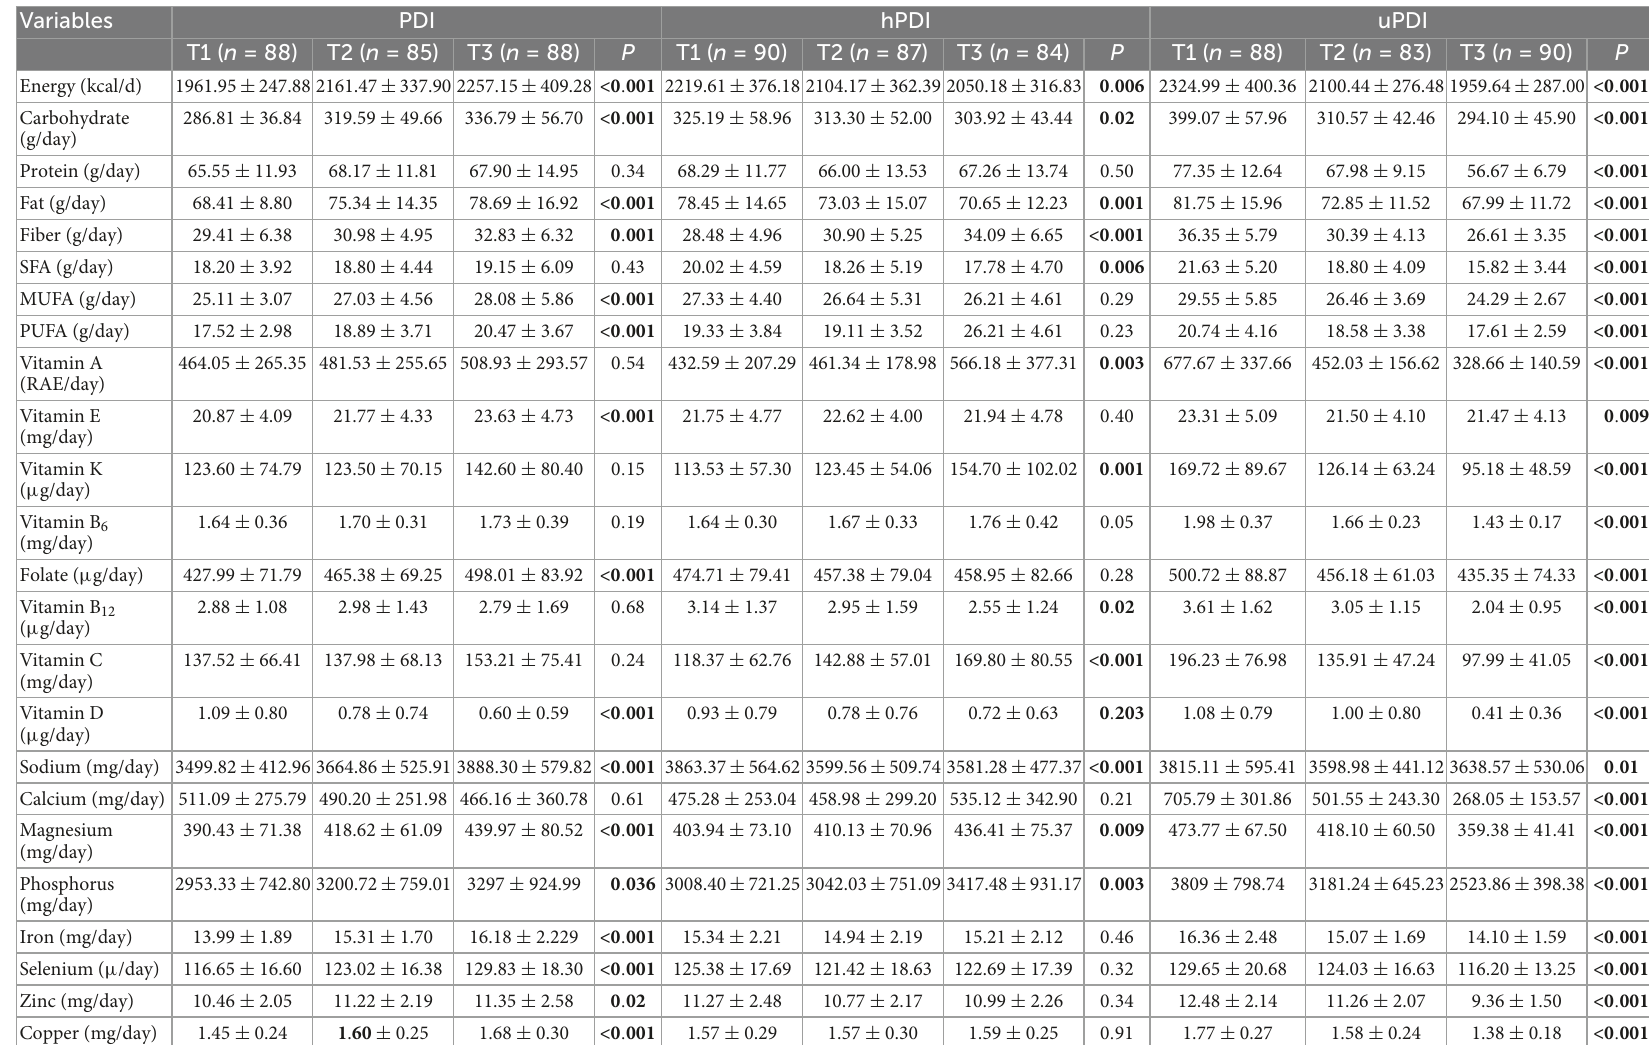
TABLE 2 Nutrients intakes between tertiles of plant-based diet index (PDI), healthy plant-based diet index (hPDI), and unhealthy plant-based diet index (uPDI).